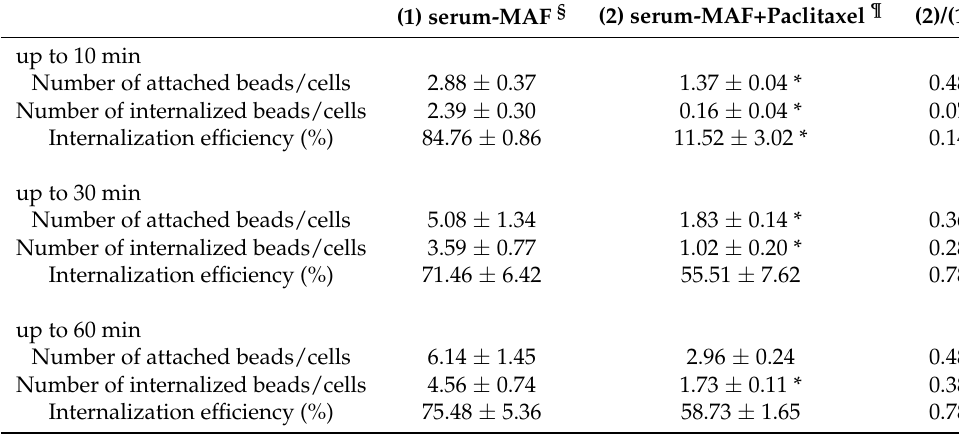
Table 2. Effect of microtubule stabilization on the beads’ internalization process in the serum-MAF- activated macrophage.